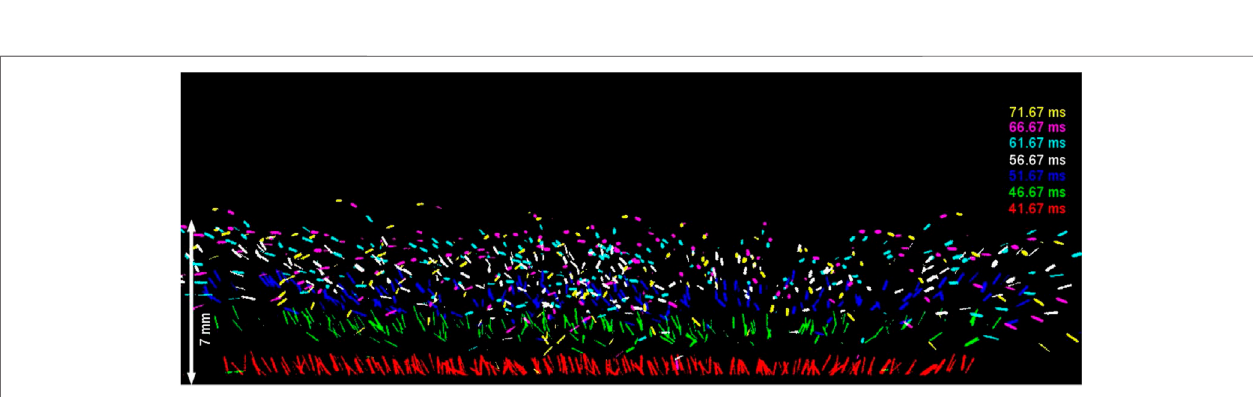
FIGURE 3 | Side-view images of microspheres bouncing from the electrode surface. This is a superposition of every third frame from the side-view camera. The bottom-mostimagewasrecordedimmediatelyat t =41.67 ms,immediatelyafterimpact,andtheotherimageswererecordedatlatertimes,asindicatedinthelegend.A bouncing microsphere has not only vertical motion but also lateral scattering, which destroys the crystalline structure that the cloud of microspheres had before impact.